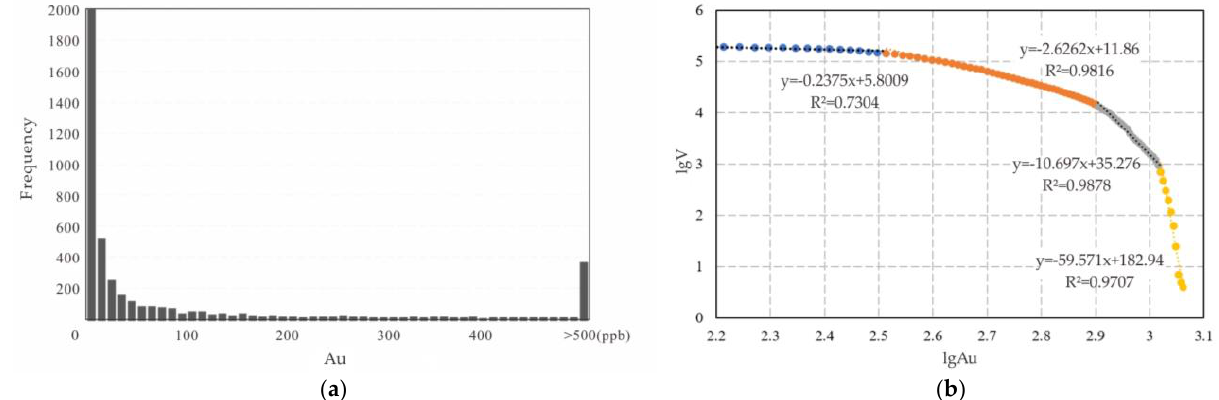
Figure 6. ( a ) Histogram of the frequency distribution of Au. ( b ) lgAu-lgV curve of the 3D data volume model. Table 1. Fractal characteristics of 3D Au data volume model.